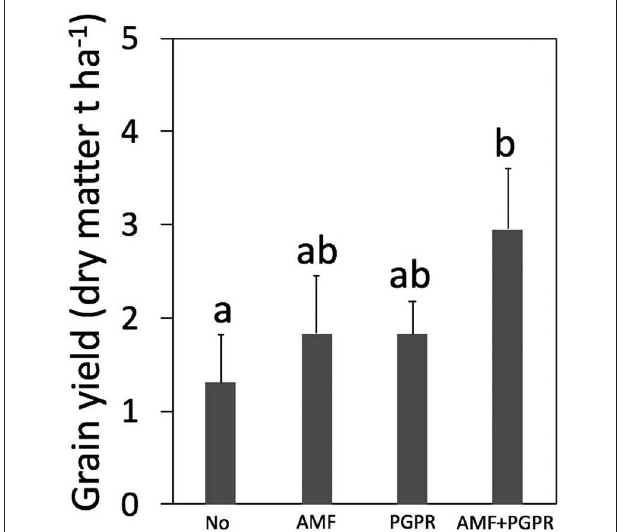
FIGURE 2 | Grain yield of finger millet as affected by single and combined microbial inoculants (AMF + PGPR) at 50% recommended dose of fertilizer (RDF) in Kolli Hills site during 2014-15. Each error bar represents + 1 standard deviation of the mean. Bars not sharing the same letters are significantly different at p <